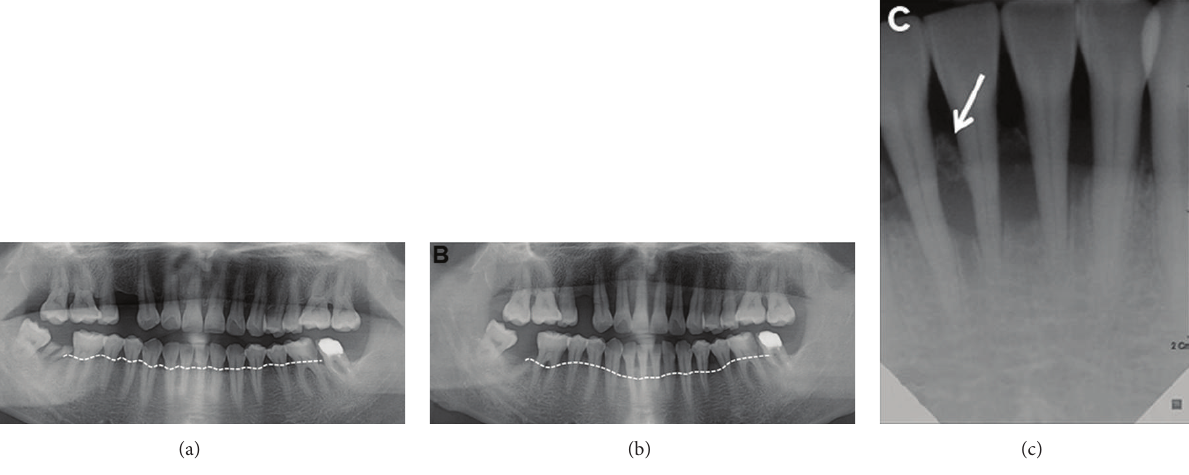
of the overall teeth, especially the lower anterior